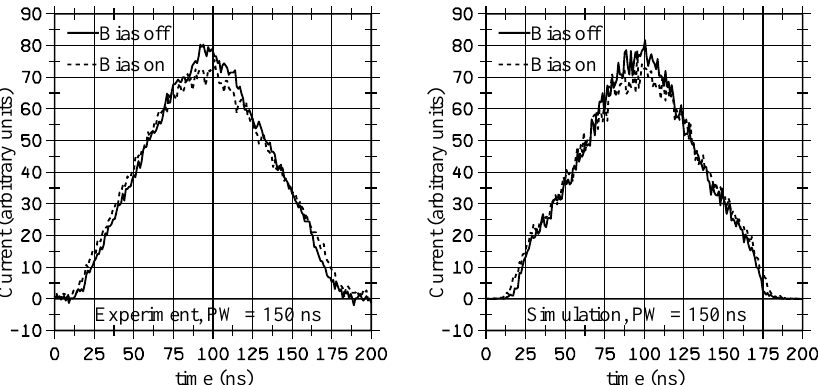
FIG. 4. Measured (left) and simulated (right) pulse shape after 625 m s, with an injected pattern width of 150 ns. The simulations used 1.2 3 10 13 protons. Solid curves represent the shape with no bias on the inductor ( 7.29 m H in the simulation). Dotted curves represent the shapes with a 900 A bias applied to the inductor ( 2.49 m H in the simulation). Buncher voltage was 7.5